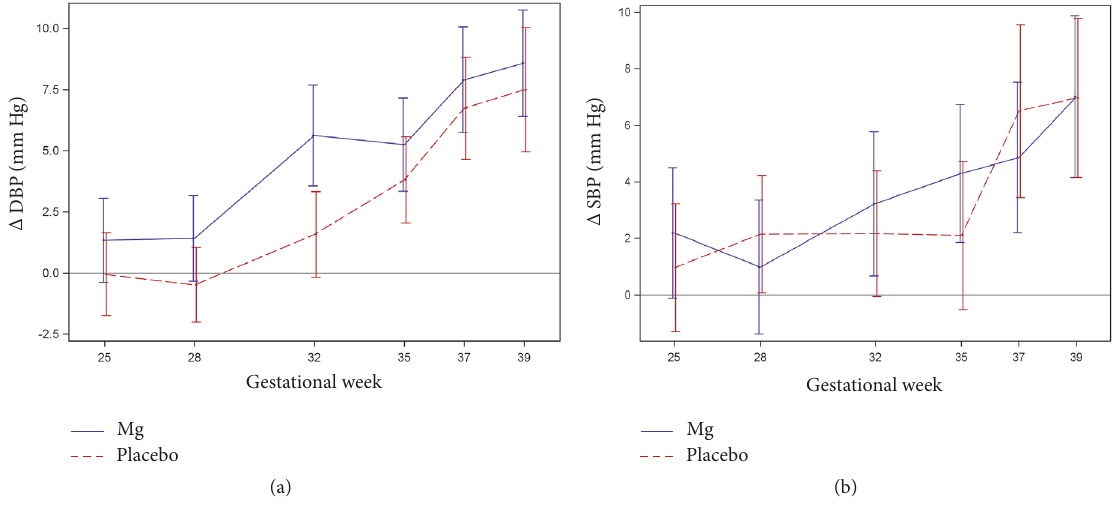
Figure 1: (a) Change ( Δ ) in DBP during pregnancy (PP). (b) Change ( Δ ) in SBP during pregnancy (PP).